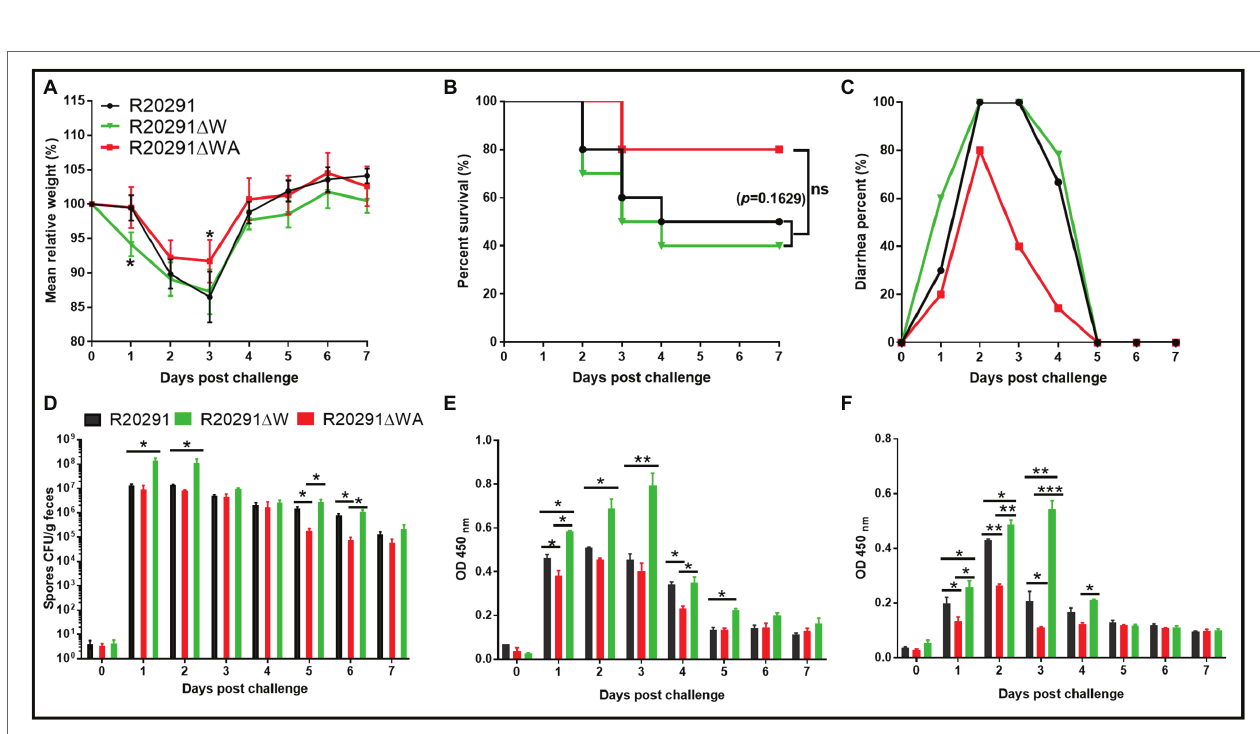
FIGURE 6 | Effects of fliW and fliW-csrA deletion on C. difficile virulence in mice. (A) Mean relative weight changes. (B) Survival curve. (C) Diarrhea percentage. (D) Clostridioides difficile in feces. (E) TcdA titer of fecal sample. (F) TcdB titer of fecal sample. Bars stand for mean ± SEM (* p < 0.05, ** p < 0.01, *** p < 0.001). One-way ANOVA with post hoc Tukey test was used for statistical significance. Animal survivals were analyzed by Kaplan–Meier survival analysis with a log-rank test of